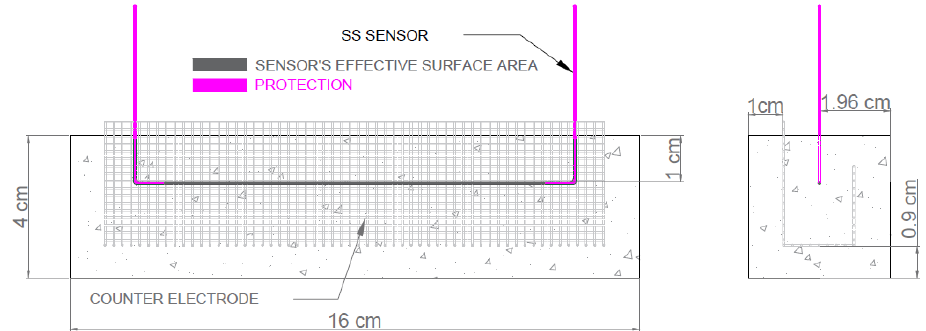
Figure 2. Diagram of the configuration of the SS sensors embedded in a concrete sample.